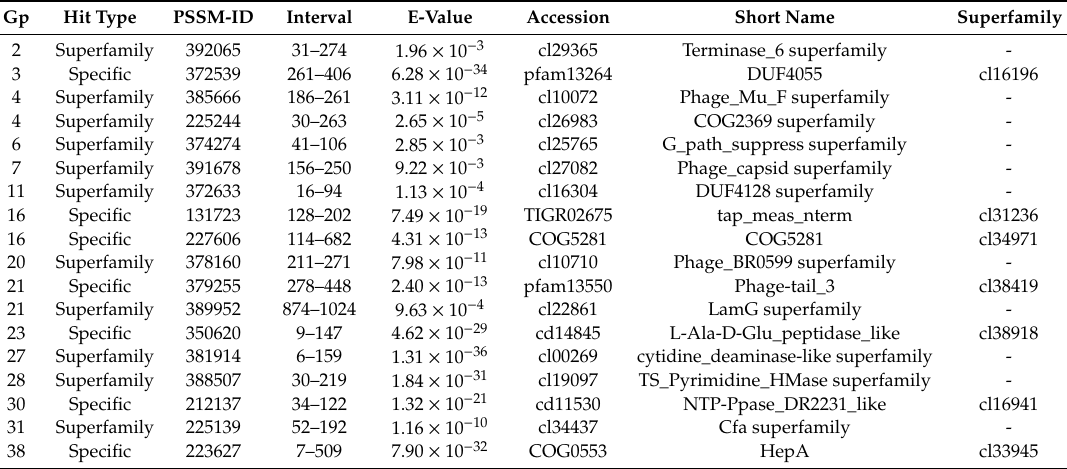
Table 3. The conserved domains found in the 65 gene products of